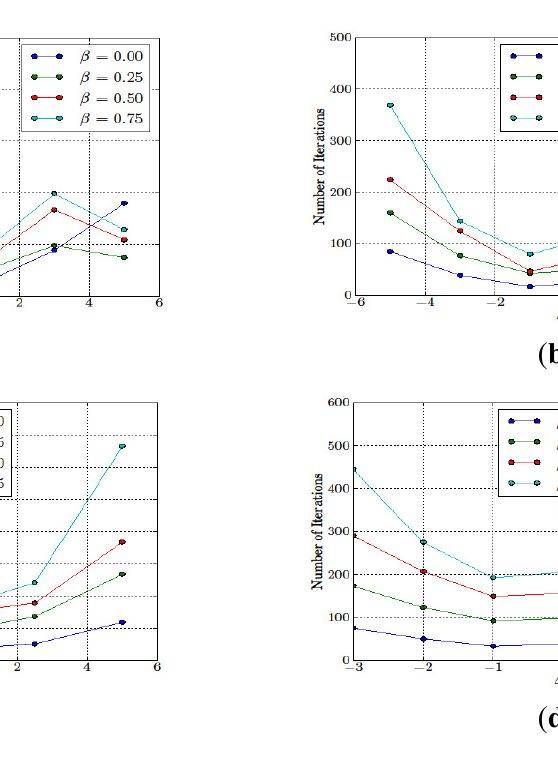
Figure 14. The effect of the initial registration errors to the number of iterations ( a ) in the x -direction; ( b ) in the y -direction; ( c ) in the scale; and ( d ) in the